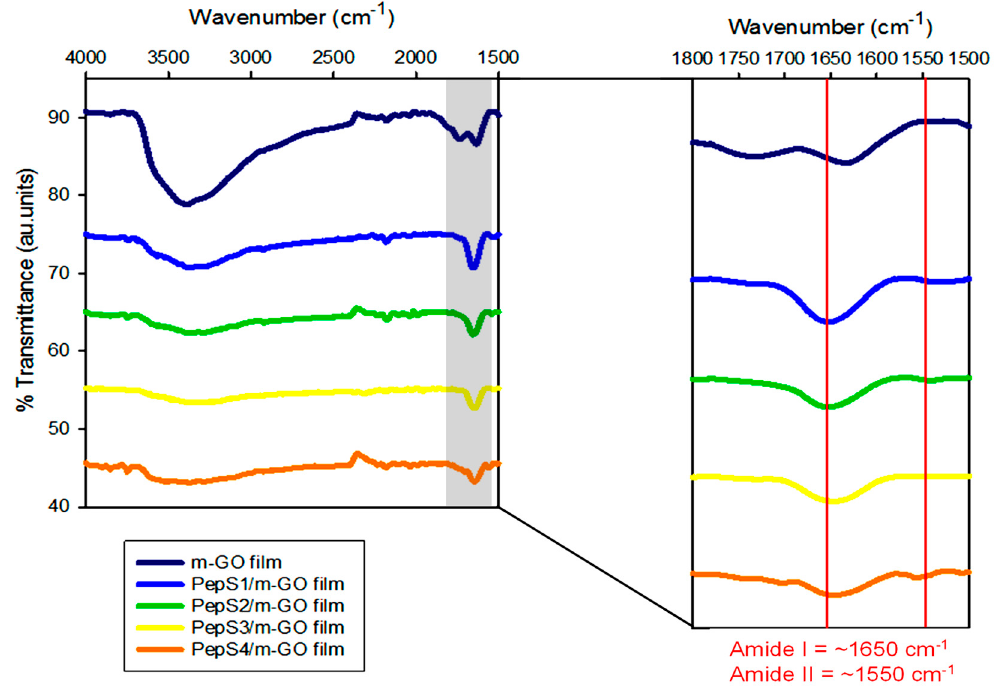
Figure 2. FTIR spectra of m-GO film and functionalized m-GO film with PepS1, PepS2, PepS3, and PepS4. The presence of carbon (C), oxygen (O), and nitrogen (N) was identified in the parent m-GO film and all peptide-conjugated m-GO films (PepS1/m-GO, PepS2/m-GO, PepS3/m-